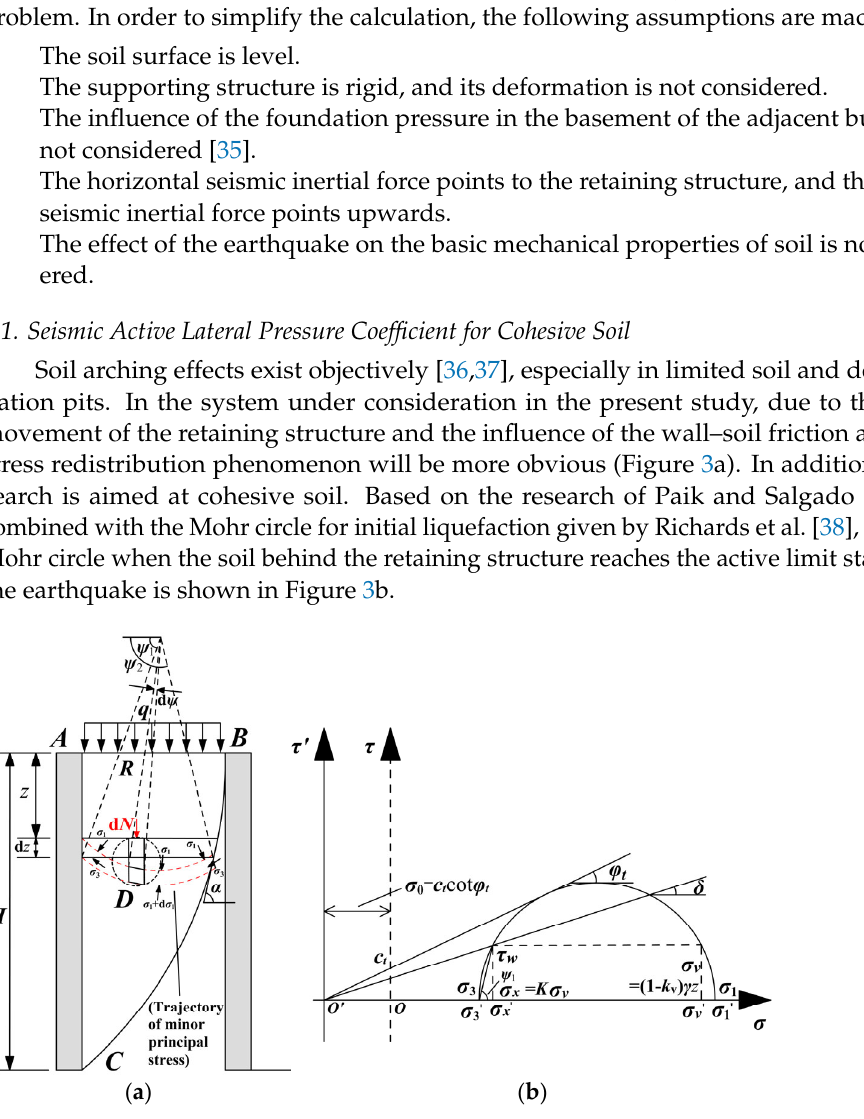
Figure 3. Arching effects in limited backfill: ( a ) trajectory of minor principal stress; ( b ) Mohr circle for stresses at the retaining structure.